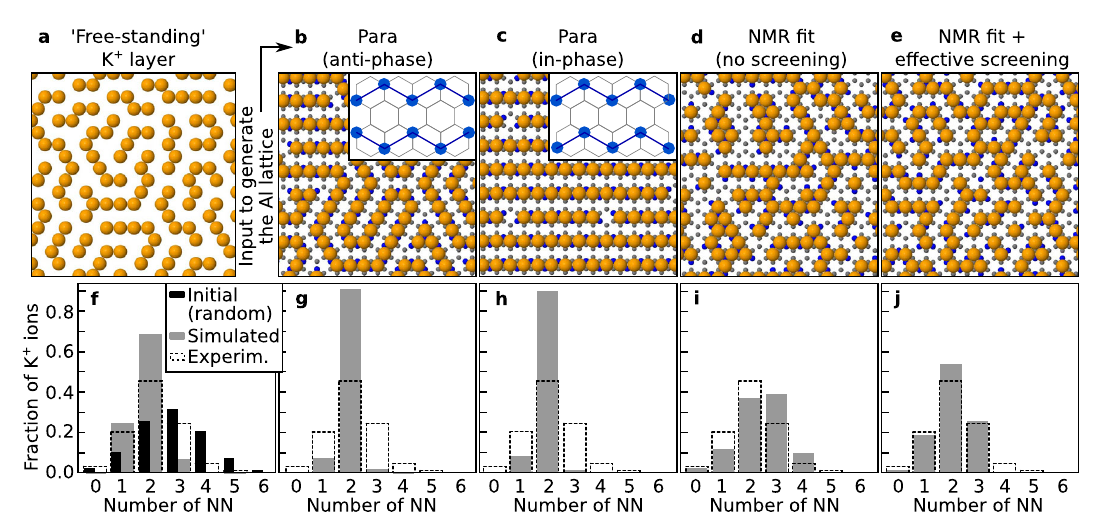
Fig. 4 | Monte Carlo simulations of K+ arrangements for different Al3+ arrangements. a Distribution of free-standing K + ions (orange). b − e Distributions ofK + ionsoverdifferentAlSi 3 lattices(Al 3+ andSi 4+ ionsareshowninblueandgray, respectively). b , c Long-range-ordered distributions of Al ions obtained assuming perfectly ordered para-only con fi gurations. d Al distribution fi tting the NMR data satisfying electrostaticconstraints on the Al positions (1or2 Al/ring,no Alnearest